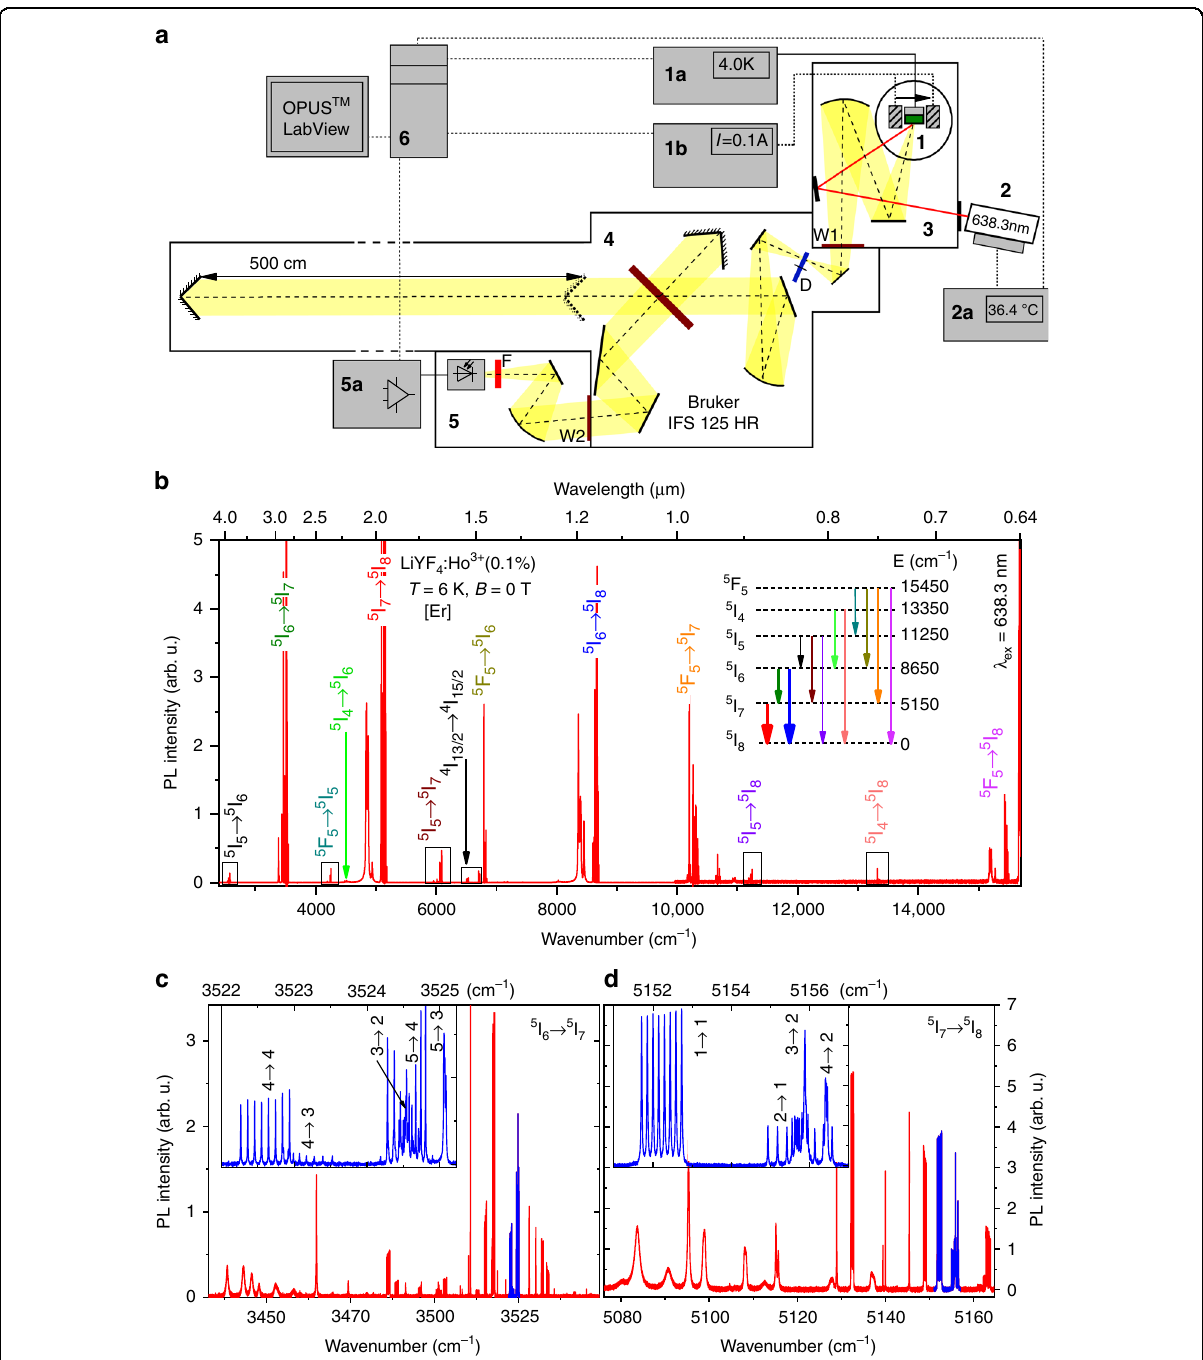
Fig. 1 PL spectrum of LiYF 4 :Ho 3 + (0.1 at. %): T = 6 K, B = 0; λ ex = 638.3 nm. a Setup: 1 — cryostat with magnetic coils (gray hatched), 1a — temperature controller, 1b — current source for magnetic coils; 2 — temperature-stabilized diode laser, 2a — temperature controller and current source for laser; 3 — PL module; 4 — Fourier spectrometer; 5 — PL registration module, 5a — preampli fi er and an analog to digital converter; 6 — workstation for spectra calculation and automatic control of magnetic fi eld and temperature. b The whole spectral region studied. Identi fi ed intermultiplet transitions of Ho 3 + as well as the 4 I 13/2 → 4 I 15/2 transition of Er 3 + trace impurity are indicated. Inset presents the scheme of energy levels of Ho 3 + ; the observed transitions are shown by arrows. c 5 I 6 → 5 I 7 and d 5 I 7 → 5 I 8 luminescent transitions. Insets show the spectral lines highlighted in blue on an enlarged scale. The numbers n i → n f indicate the initial and fi nal levels of the corresponding transition, numbered from the lowest level in the CF multiplet (Table